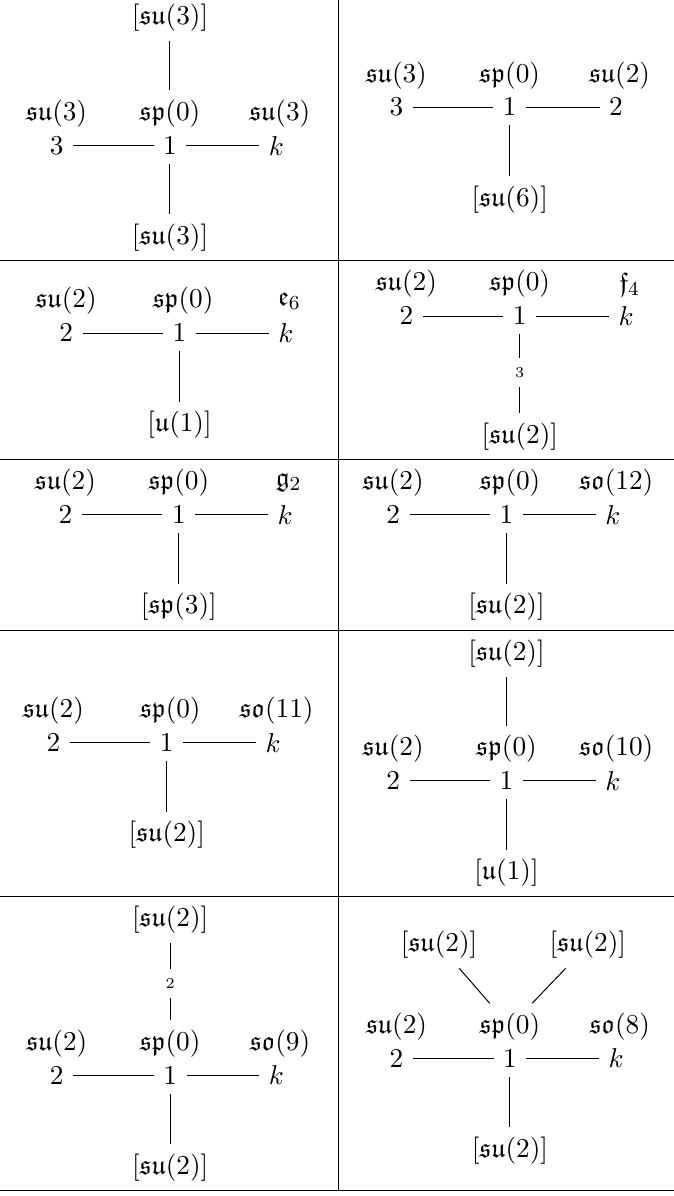
Table 5 . Possible localized flavor symmetries for nodes with a trivial gauge algebra continued from table 4. Continued in table